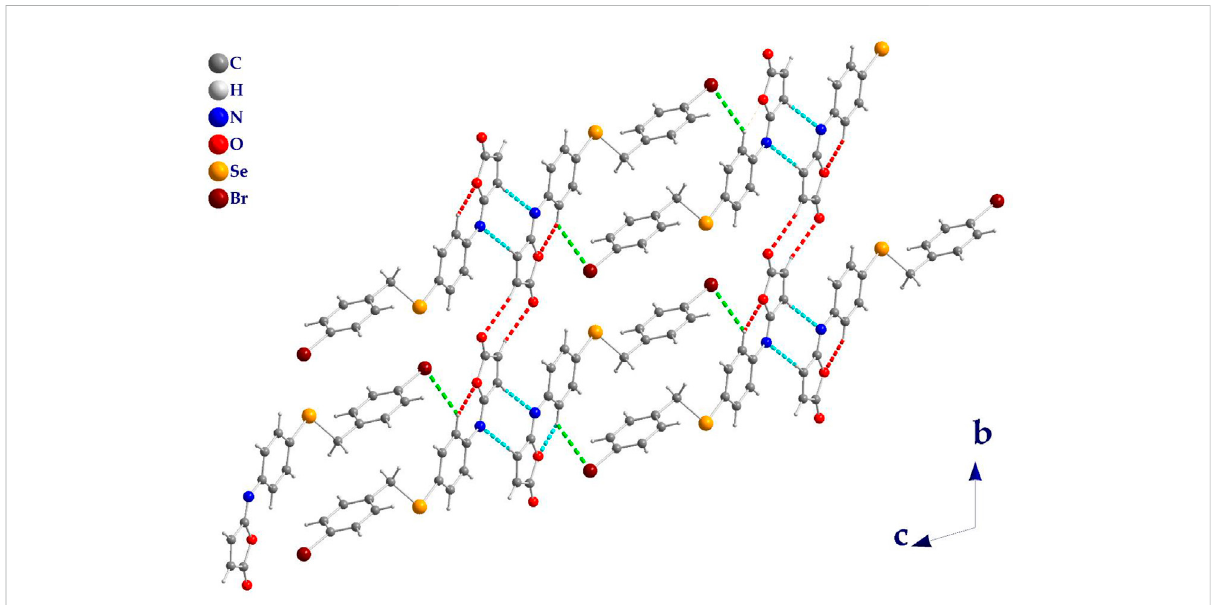
FIGURE 2 Isomaleimide 4 packing diagram, viewed along a axis, showing the hydrogen-bonded chains structure (dashed line). C-H ··· O (Red), C-H ··· N (Cyan), and C-H ··· Br (Green).